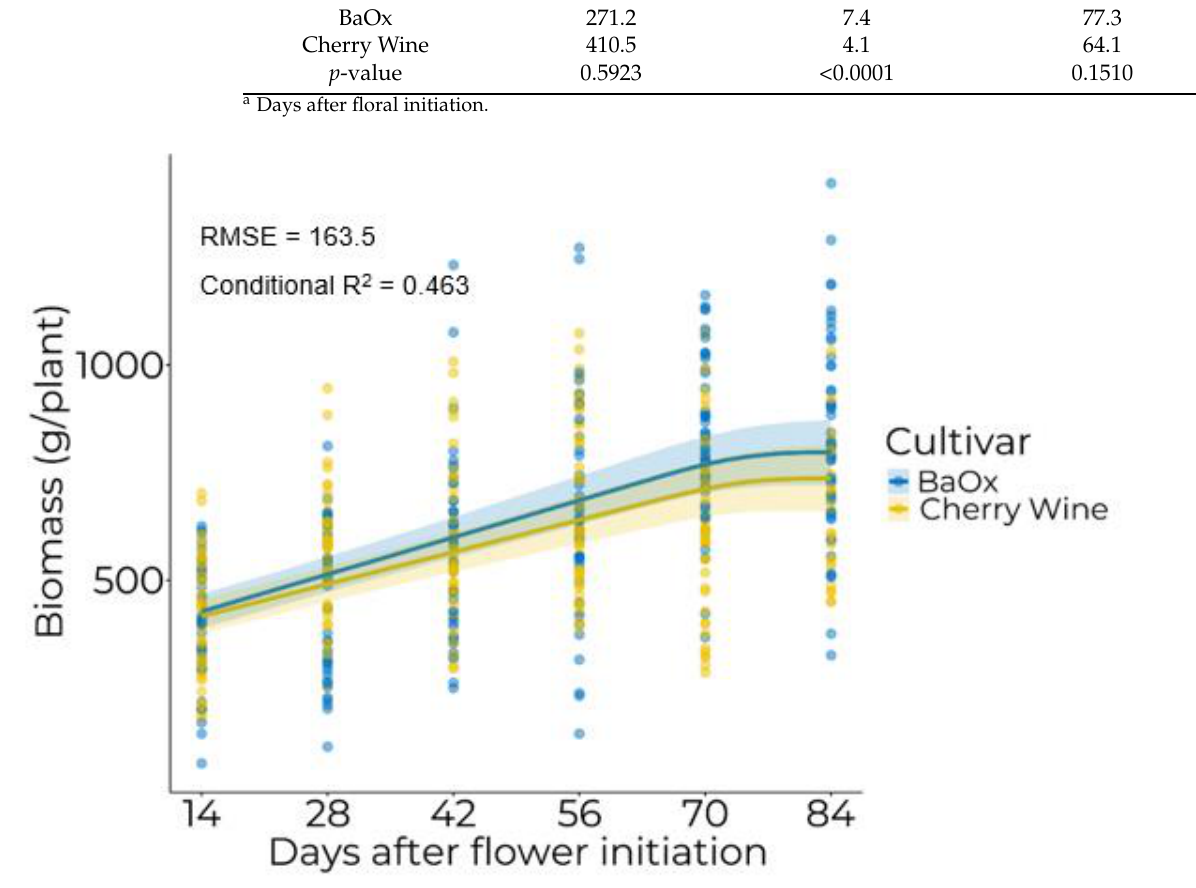
Figure 1. Linear-plateau regression for per-plant biomass over time as affected by days after flower initiation. Shaded area represents 95% confidence interval for the predicted model. Circles represent plot-level data points. RMSE = Root Mean Square Error.